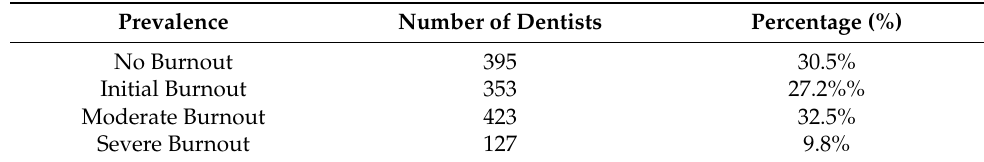
Table 1. Distribution of the dentists participating in the study according to their degree of burnout severity.